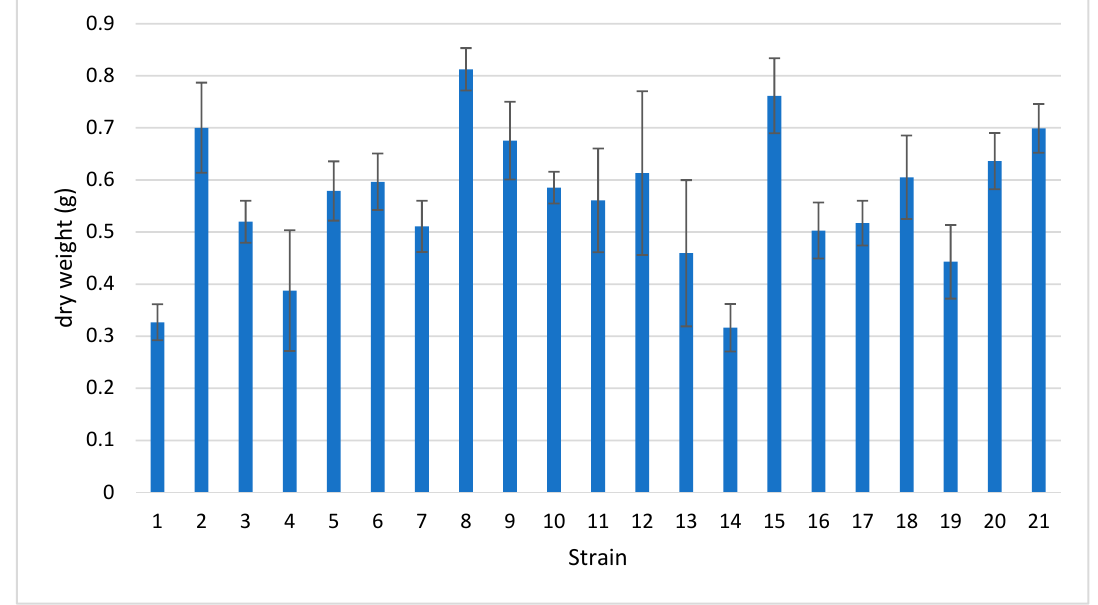
Figure 3. Average dry weight of mycelial mats obtained using the patented method (three repetitions each). The bars represent the standard error.